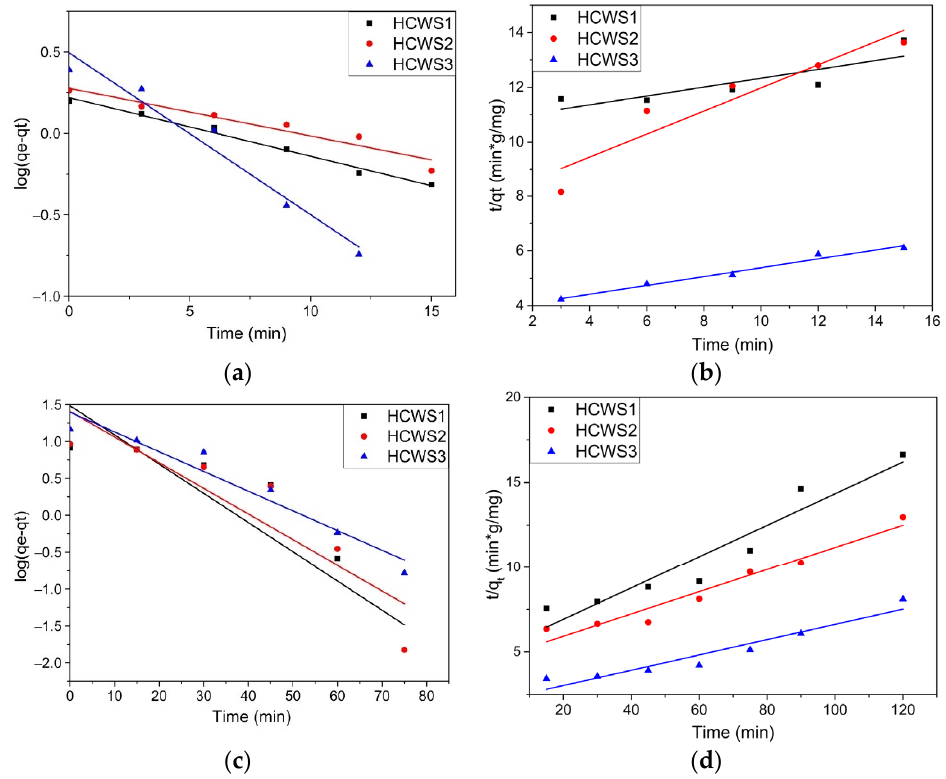
Figure 6. PFO kinetic model for ( a ) MB and ( c ) PRM, and PSO kinetic model for ( b ) MB and ( d ) PRM. Table 1. Kinetic parameters for MB and PRM retention while using the WS-derived